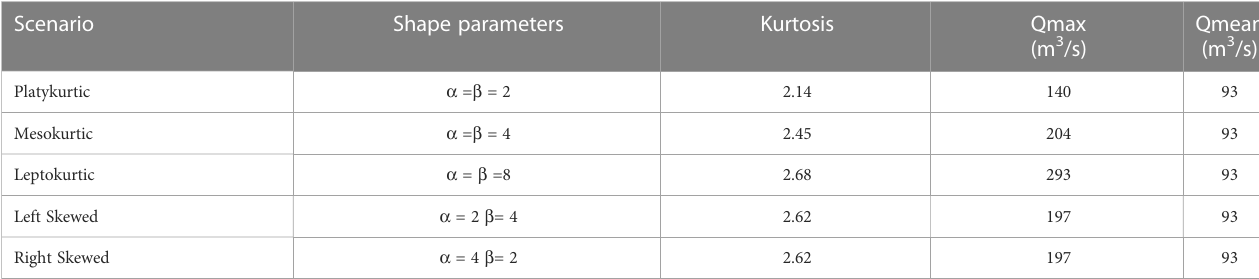
TABLE 1 Statistical parameters for each hydrograph